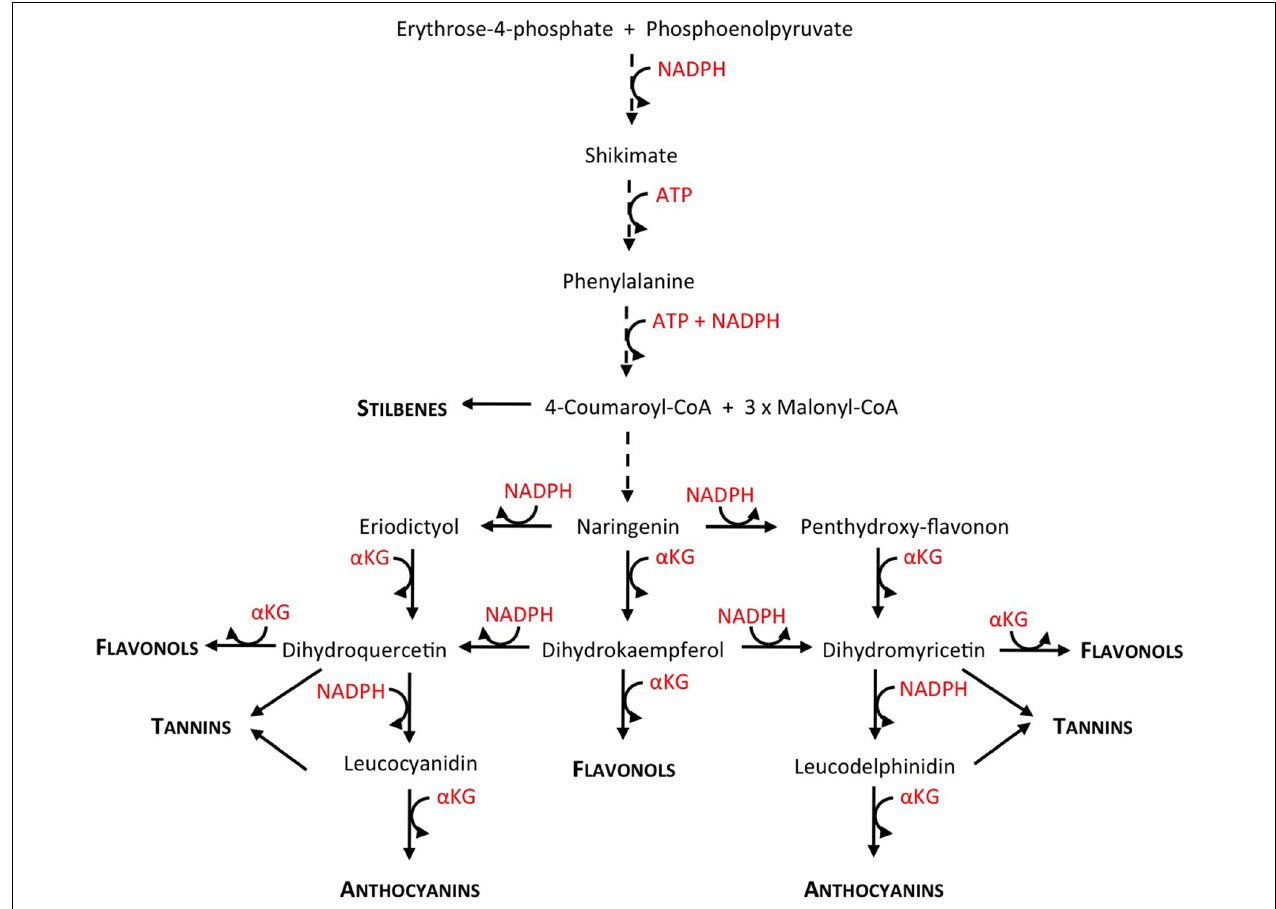
FIGURE 1 | Comprehensive view of the polyphenol biosynthetic pathway, showing NADPH, ATP, and α KG consumption (reconstructed from KEGG pathway database http://www.genome.jp/kegg/pathway.html). Dashed line arrows indicate more than one enzymatic step. Biosynthetic intermediates are written in regular letters, end products in small capitals and